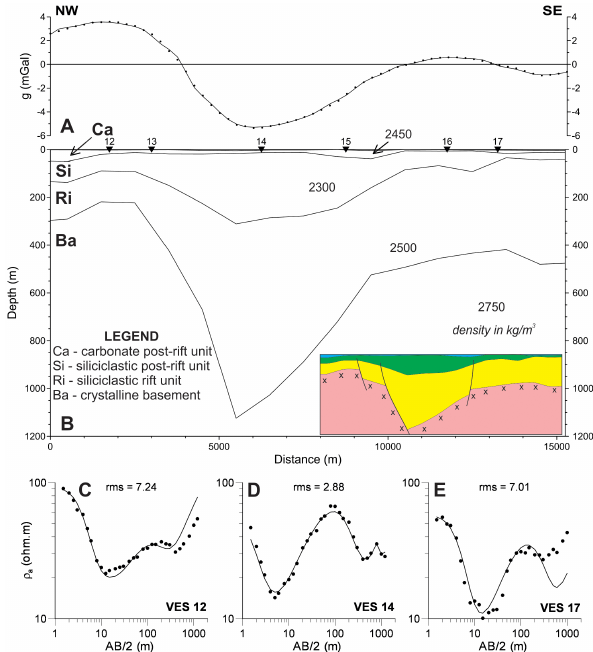
Figure 8. Observed (dots) and calculated (solid line) gravity anomaly across profile 01 (a) and the final model response obtained from joint inversion method (b) . Comparison of three VES data (dots) and model responses of the gravity–geoelectric joint inver- sion (c–e) . rms: VES misfit (per cent).